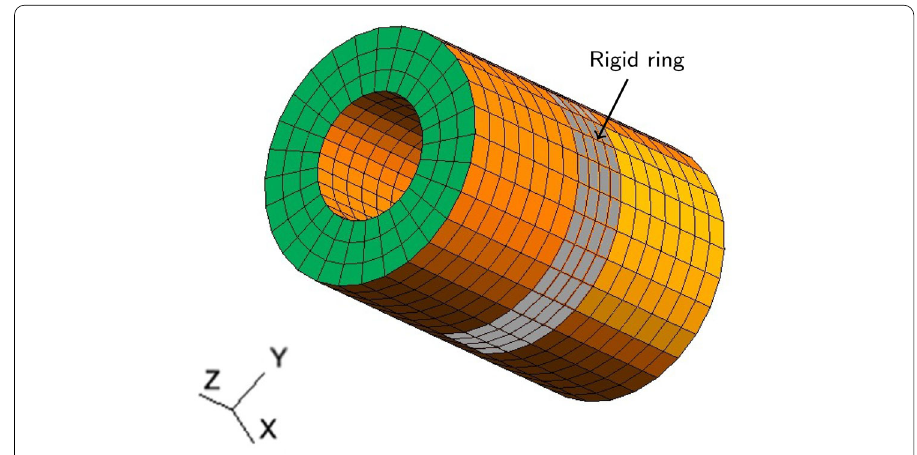
Fig. 1 Cylinder with rigid ring and Dirichlet boundary conditions